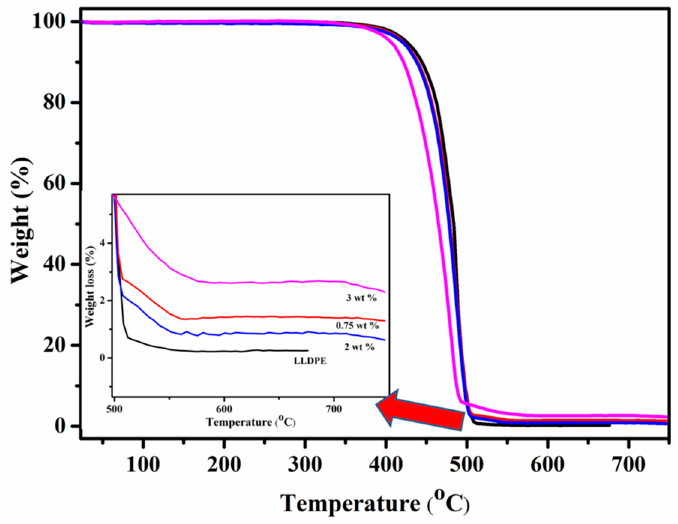
Figure 9. Thermogravimetric analysis (TGA) curves of CTAB–MoS 2 /LLDPE composites.